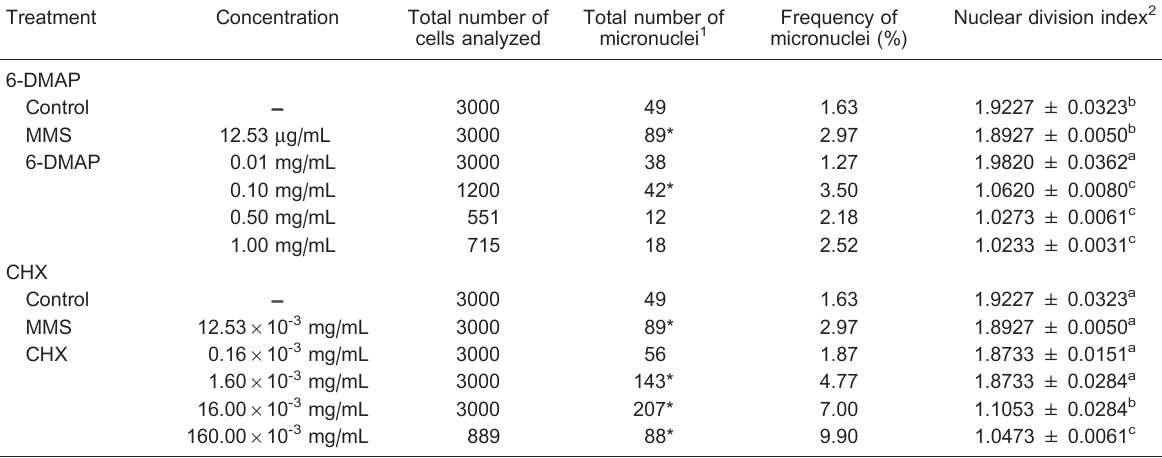
Table 3. Total number of cells analyzed, total number of micronuclei, frequency of micronuclei, and cell division index in the micronucleus test with cytokinesis block in the HepG2 cells. Treatment